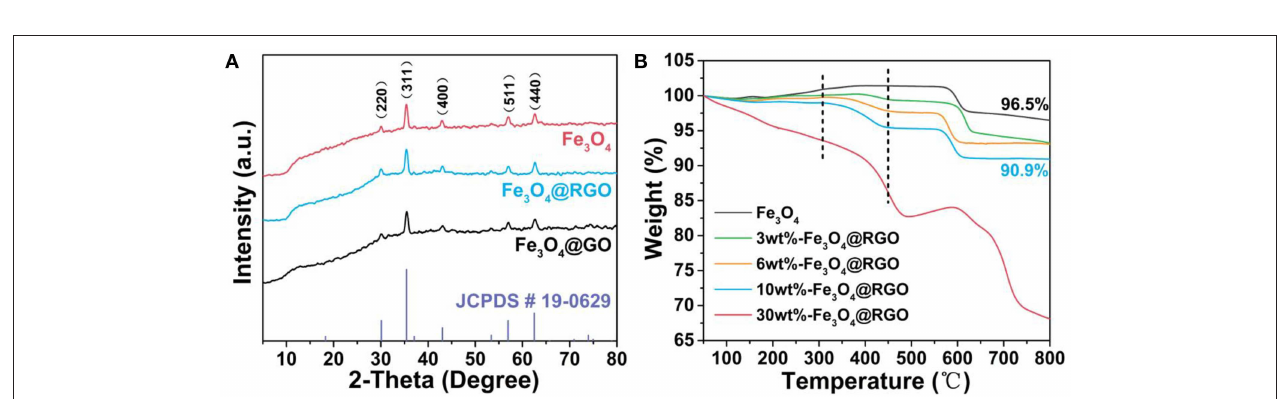
FIGURE 3 | (A) XRD patterns of pure Fe 3 O 4 , 10wt%-Fe 3 O 4 @GO and 10wt%-Fe 3 O 4 @RGO, and the standard patterns of Fe 3 O 4 phase (JCPDS card 19-0629). (B) TGA curves of pure Fe 3 O 4 and the different material mass ratio of the Fe 3 O 4 @RGO.